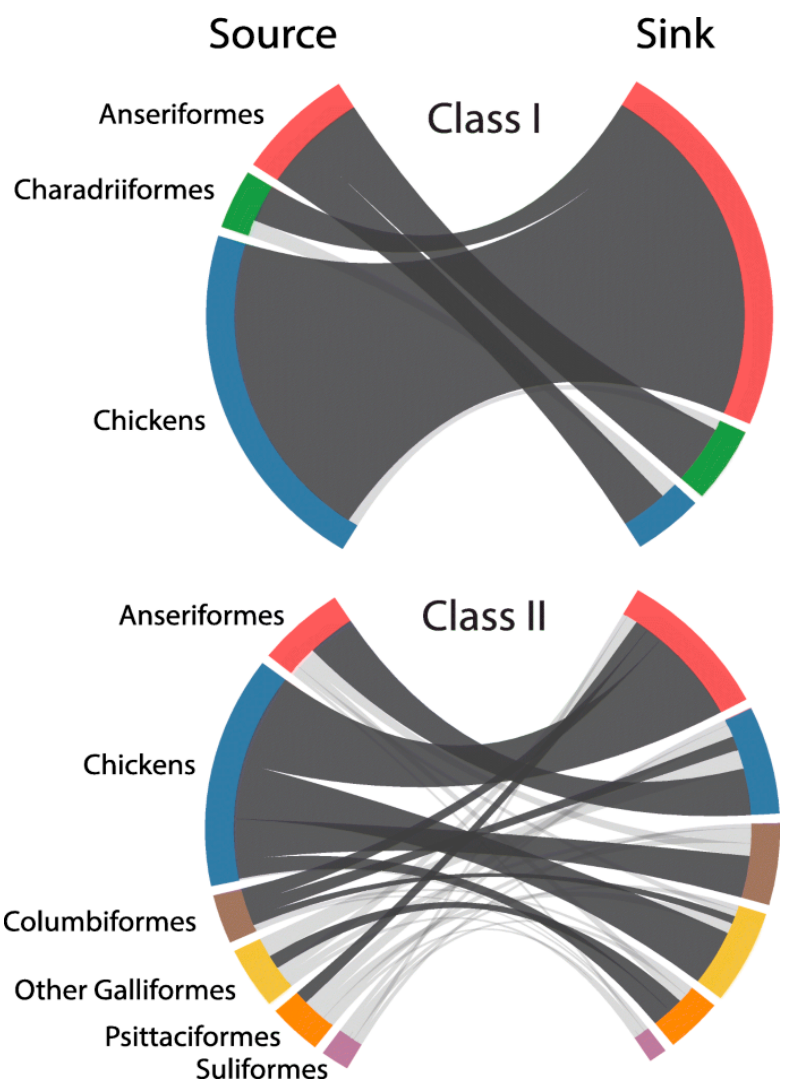
Figure 3. Inter-host transmission of Newcastle disease viruses (NDV). Excerpts from Figure 2 in Hicks, J.T.; Dimitrov, K.M.; Afonso, C.L.; Ramey, A.M.; Bahl, J. Global phylodynamic analysis of avian paramyxovirus-1 provides evidence of inter-host transmission and intercontinental spatial diffusion [64] Class I and class II chord diagrams representing the fully resolved transition matrix between host orders. Chord width between source and sink host state is proportional to the median transition rate per year. Dark gray chords are statistically supported (BF > 3.0). Colors correspond to host order: Anseriformes—red, Charadriiformes—green, domestic chickens—blue, Columbiformes—brown, other Galliformes—yellow, Psittaciformes—orange, Suliformes—purple. This nucleotide-based analysis demonstrated the capacity for NDV to transmit among divergent host taxa over time (Figure 3). The highest (most strongly supported) transition rate for viruses of class I and II existed from domestic chickens to Anseriformes, and among class II viruses for domestic chickens acting as a source for Columbiformes, other Galliformes, and Psittaciformes. Columbiformes was also highly supported sources of viruses to Anseriformes and domestic chickens. Notwithstanding the evidence of the existence of different transmission rates of NDV among different hosts species; some re- strictions appeared to exist as virulent NDVs were not repeatedly isolated in migratory